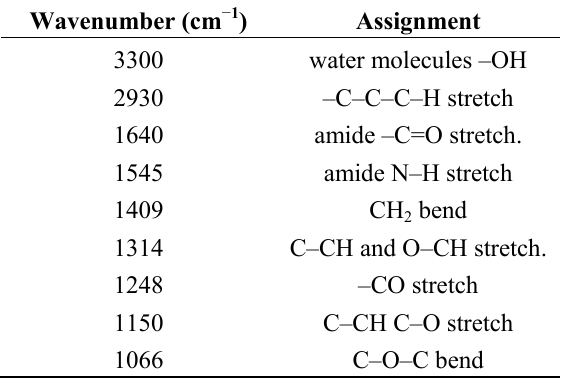
Table 6. Peak wavenumbers (cm − 1 ) and assignments for CHT